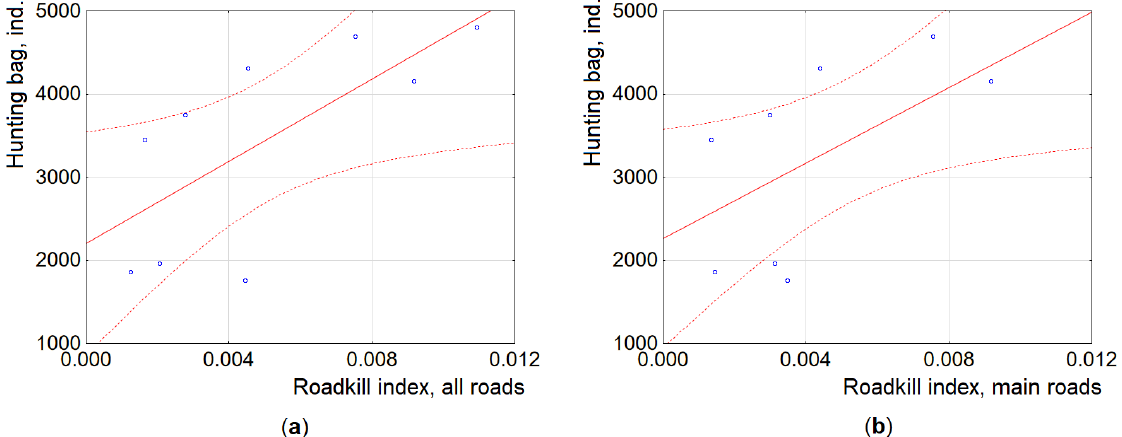
Figure 4. Correlation of roadkill index and raccoon dog hunting bag at the country scale, 2012–2020, presenting averages for all types of roads ( a ) and main roads ( b ). Dashed lines show 95%